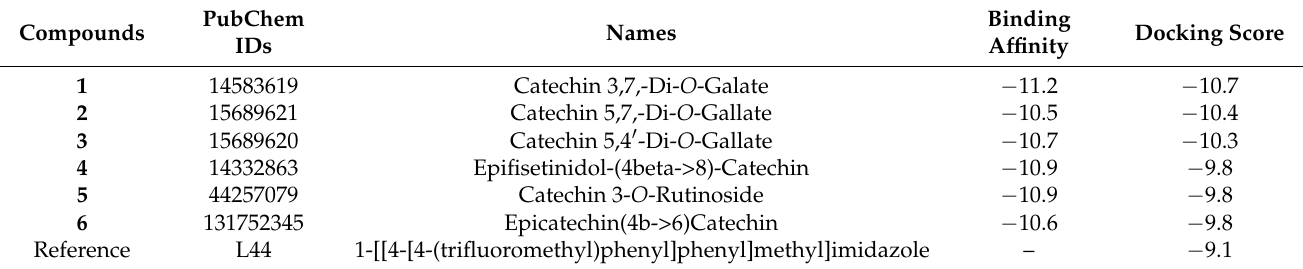
Table 1. Redocking scores of top 10 compounds produced after virtual